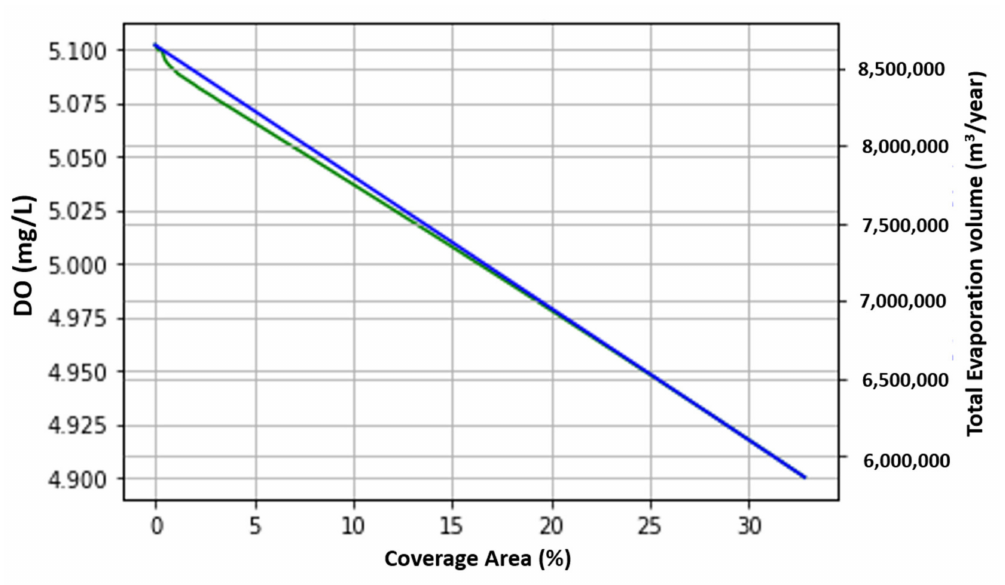
Figure 13. Case (a): The relation between covered area, DO, and evaporation volume by applying the condition of DO concentration of 5 mg / L.